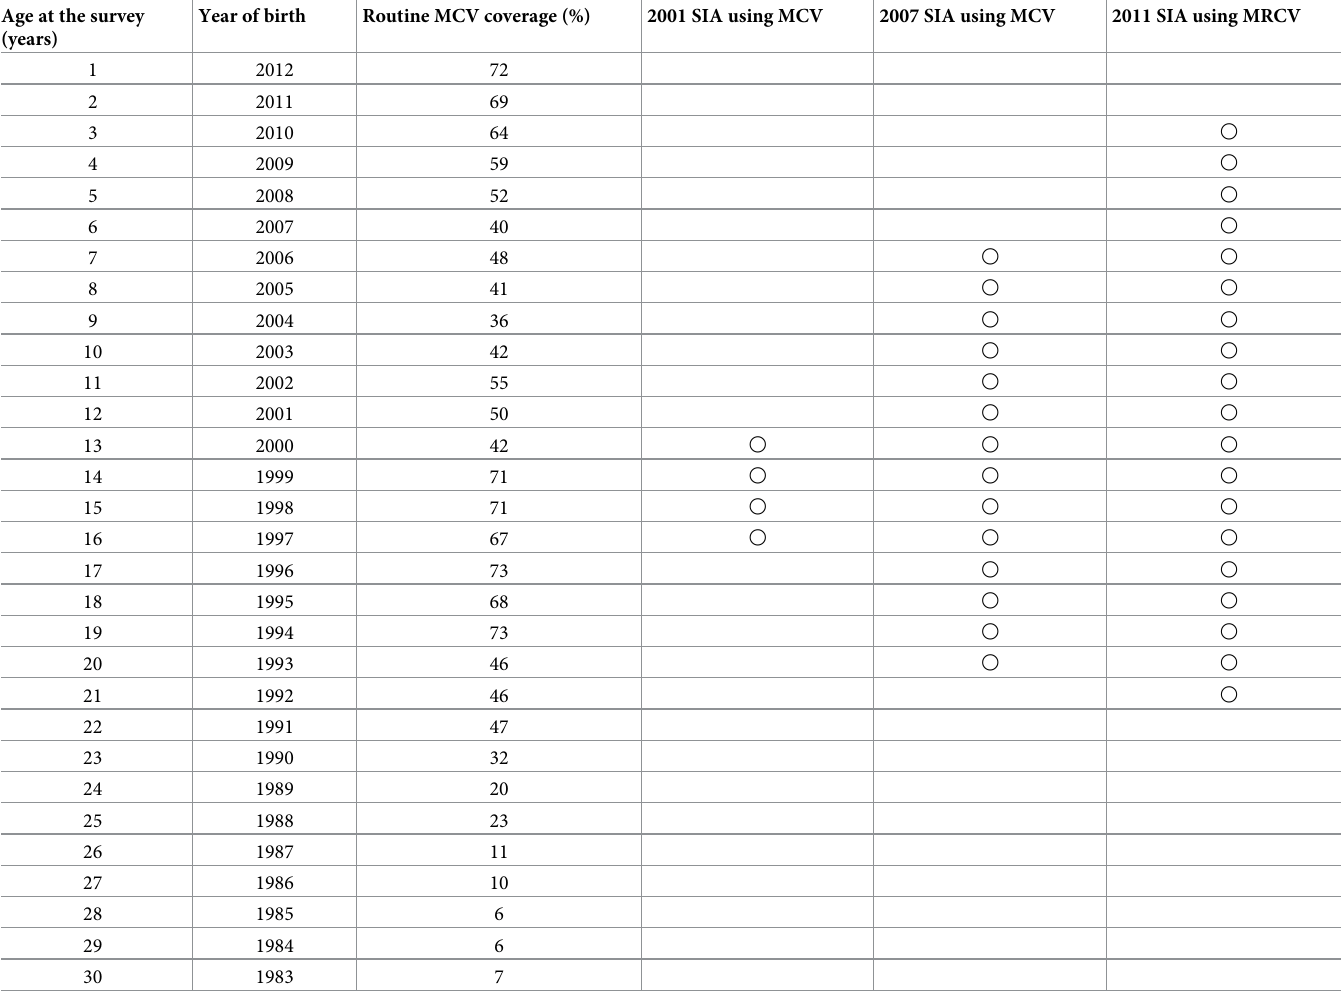
Table 1. Reported coverage of routine immunization and supplementary immunization activities with measles containing vaccine by age at the survey in Lao PDR, 2014 (cid:3) . Age at the survey